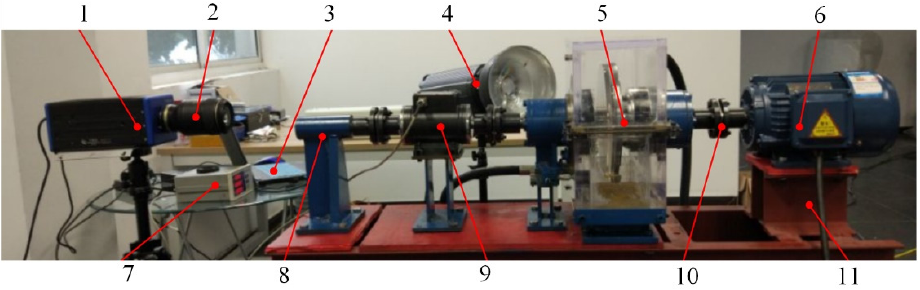
Figure 21. Design of transparent test platform (1 = high-speed camera; 2 = lens; 3 = computer; 4 = fill light; 5 = host; 6 = motor; 7 = data collection unit; 8 = magnet powder brake; 9 = torque sensor; 10 = coupling; 11 = base). The hydraulic system provides lubricating fluid to the transparent host and cools the system, as shown in Figure 22. The system comprises a pressure gauge, relief valve, gear pump, oil tank, speed control valve, flow meter, and cooler, etc. The gear pump sends the lubricating fluid into the transparent host to fill the gap of the friction pair and then flows back into the oil tank through the return port at the bottom.